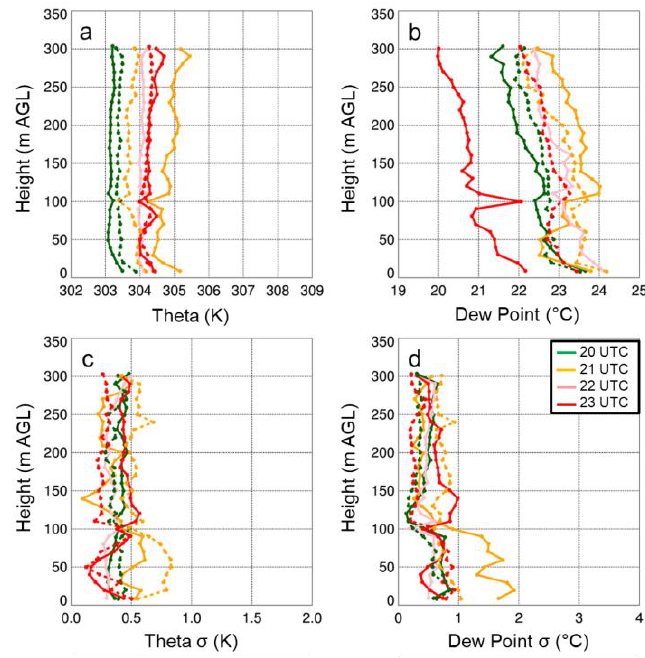
Figure 12. Vertical profiles of potential temperature ( a ) and dew point ( b ) as a function of height for select sUAS flights with the DJI S-1000 (solid) and MD4-1000 (dashed) sUAS on 15 August 2017. Panels ( c ) and ( d ) show the standard deviation in potential temperature and dew point, respectively. Green, orange, pink, and red lines coincide with flights made starting at 2000 UTC, 2100 UTC, 2200 UTC, and Sensors 2019 , 19, 10 FOR PEER REVIEW 2310 UTC, respectively. Data were binned every 10-m AGL.